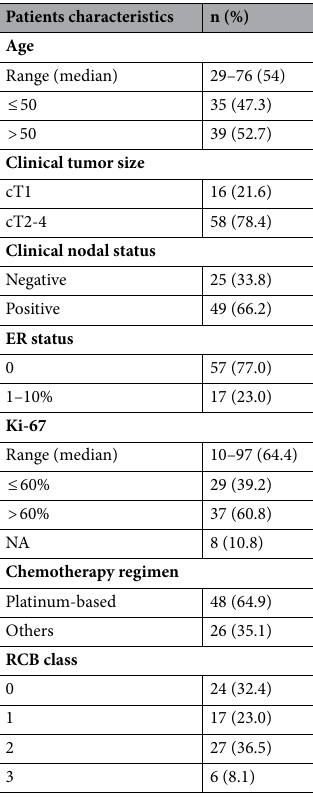
Table 1. Patients characteristics. ER: estrogen receptor, RCB: Residual cancer burden, NA: Not